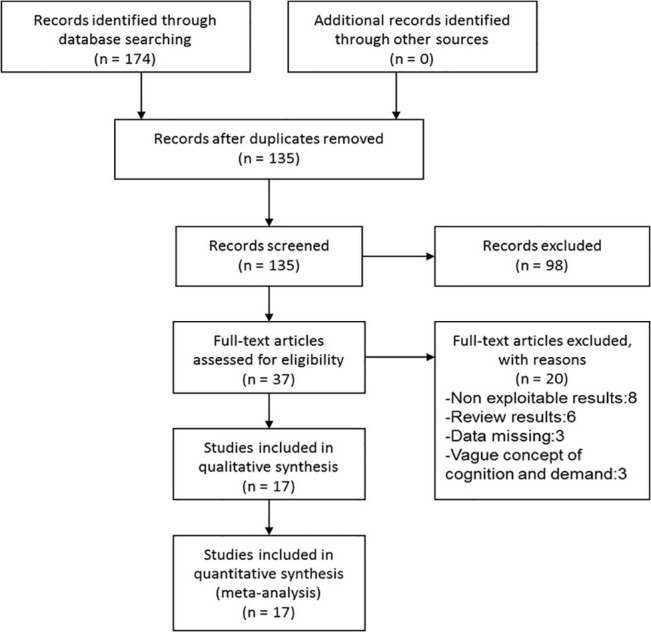
Flowchart of the Included Studies.